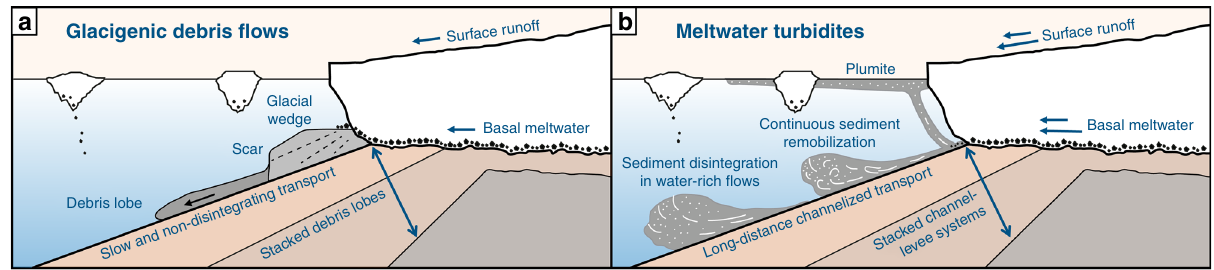
Fig. 1 Two types of sedimentary systems forming trough mouth fans. a Glacigenic debris fl ow dominated model implying temporarily stored sediment (glacial wedge) and non-disintegrating sediment transport. b Meltwater dominated model implying continuous channelized sediment transport in water- rich fl ows and surface plumites. Arrows indicating glacial meltwater are conceptual and not absolute